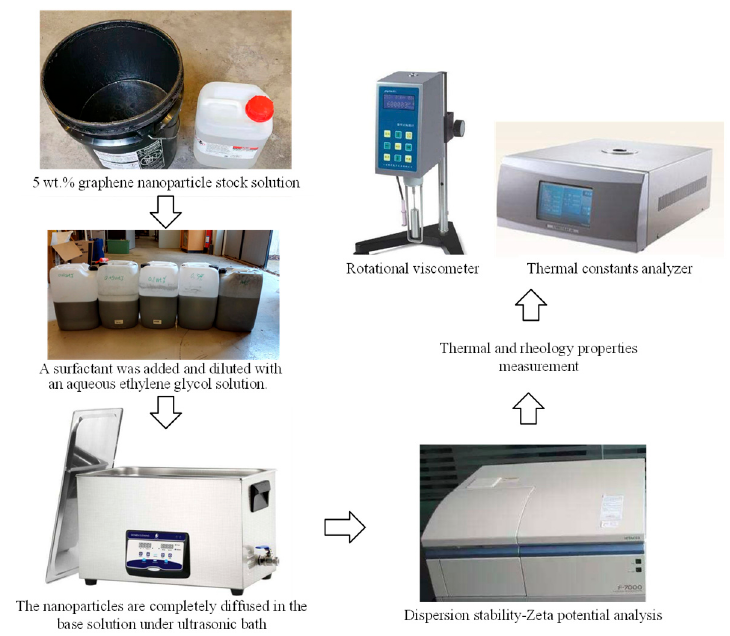
Figure 3. Graphene nanofluid preparation and the physical property measurement process.